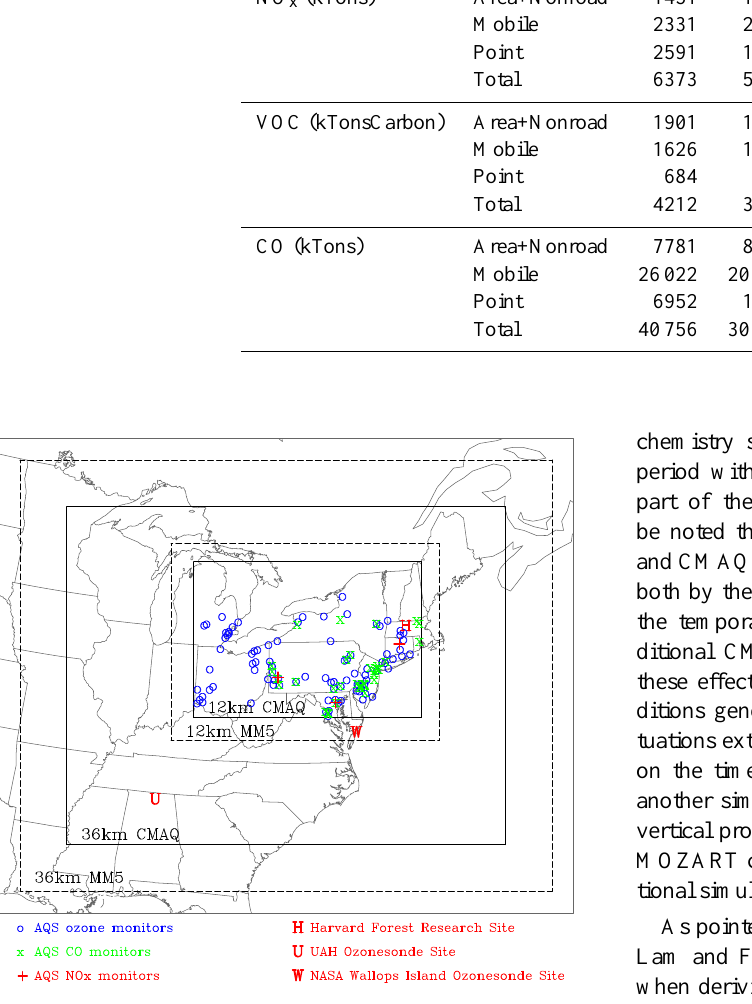
Fig. 1. Maps depicting the MM5 and CMAQ modeling domains and the location of the observation stations used in this